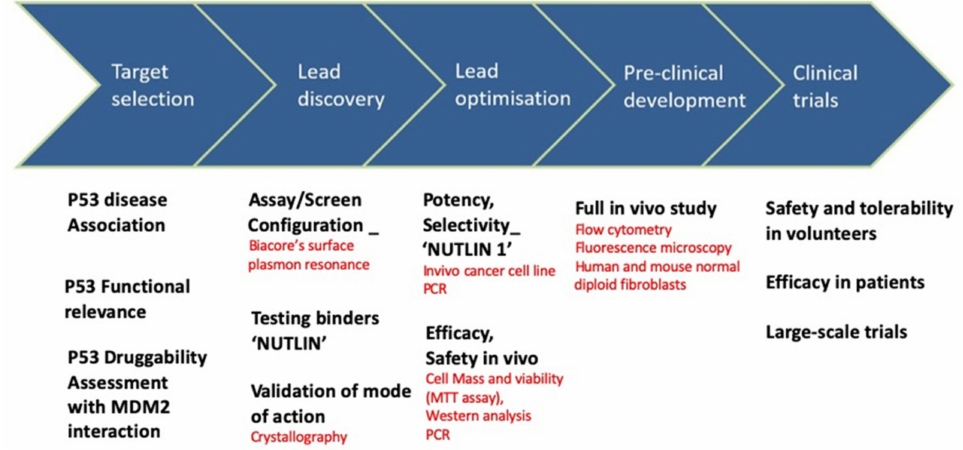
Figure 4. Nutlin: drug discovery and development and associated